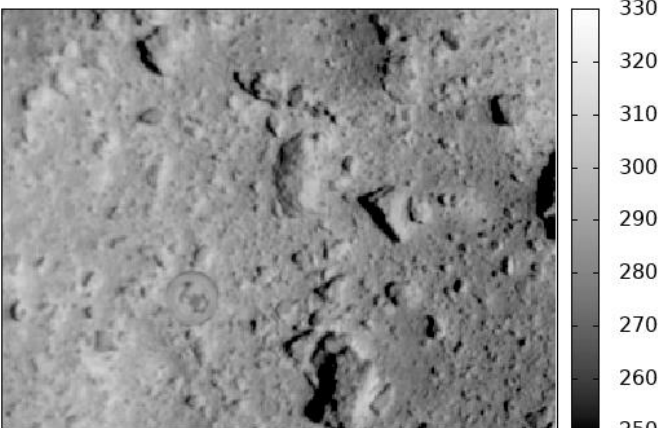
Figure 7. Thermal image of the Small Carry-on Impactor (SCI) released from Hayabusa2 spacecraft taken by TIR on 5 April 2019, at the altitude of 500 m. The shape and the attitude of the SCI was recognized in thermal images against the background of asteroid surface. A movement of SCI with its small nutation was observed in this image. The temperature scale is in Kelvin. (Image: hyb2_tir_20190405_015705_l2.fit, © JAXA).